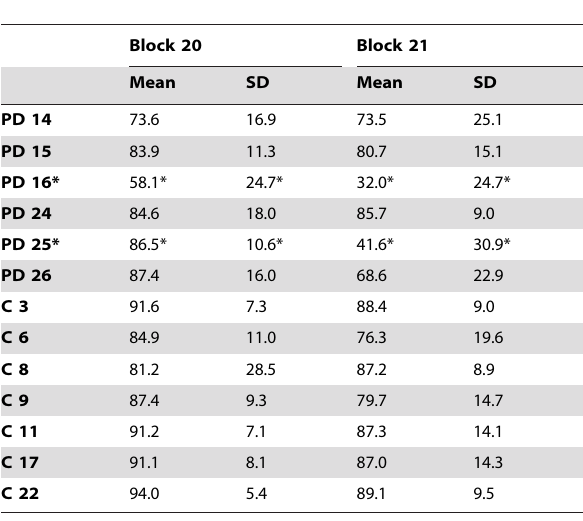
Table 3. Mean and SD of performance score of the PD patients (PD) and control subjects (C) for the long-term retention session.